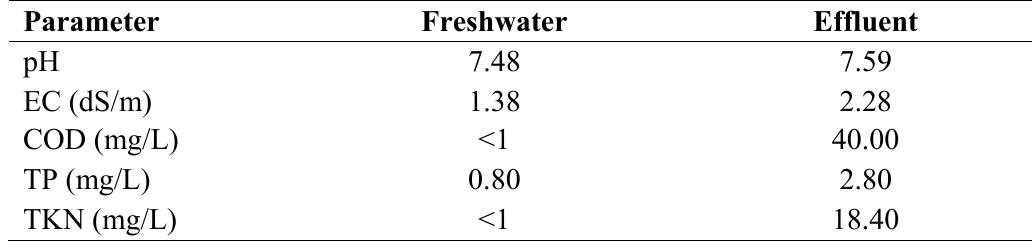
Table 1. Average values of chemical parameters in freshwater and effluent samples.